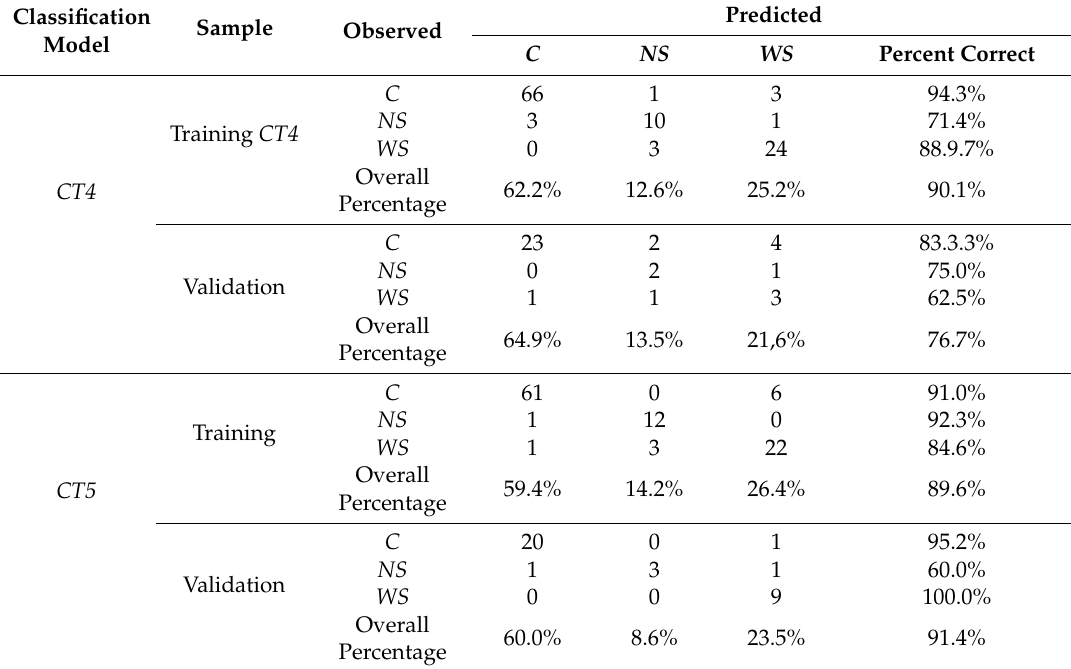
Table 1. The classification accuracy of the training and testing sample for calibration and